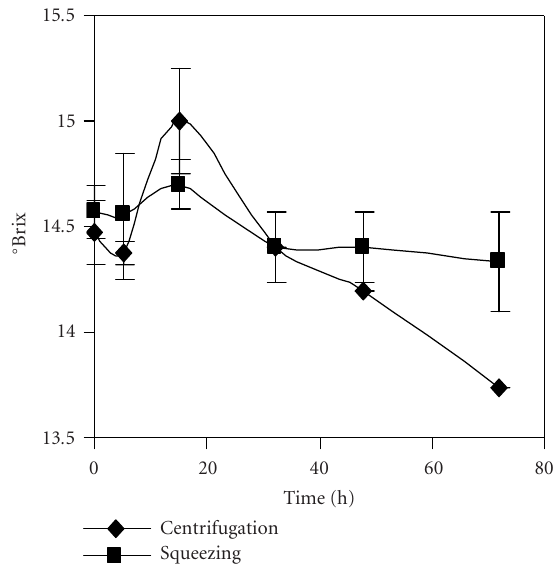
Figure 9. Evolution of pH of pomegranate juices obtained by centrifugation of seeds and by the squeezing of fruit halves with an electric lemon squeezer and stored for 72 hours at 4 ◦ C. Bars represent standard deviation of 4